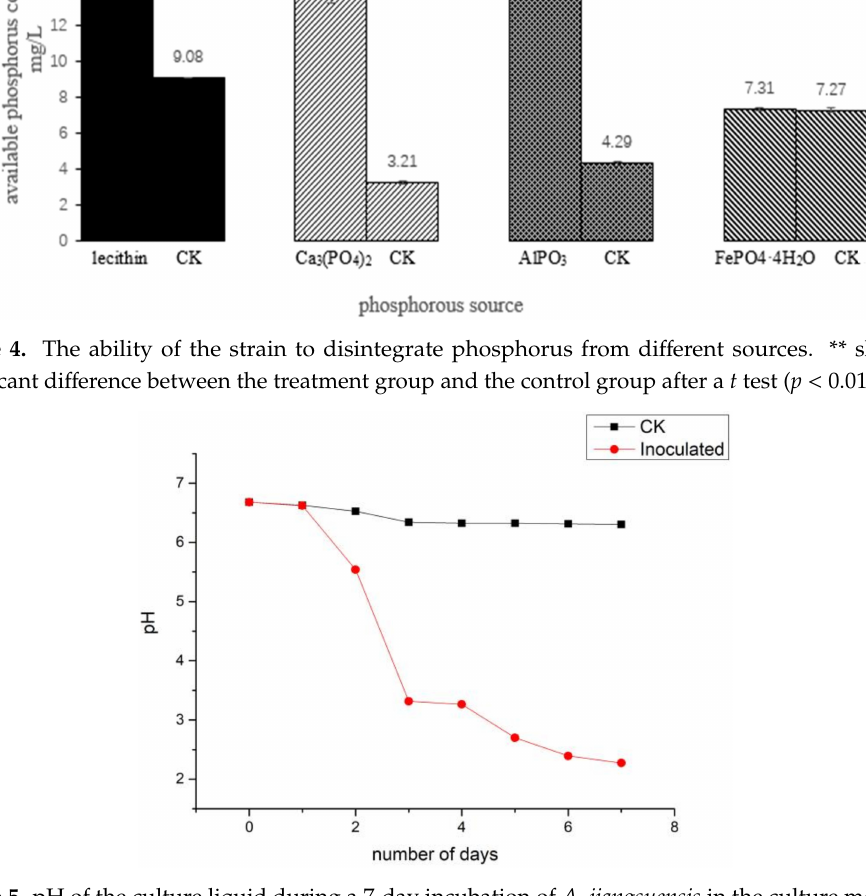
Figure 5. pH of the culture liquid during a 7-day incubation of A. jiangsuensis in the culture medium.